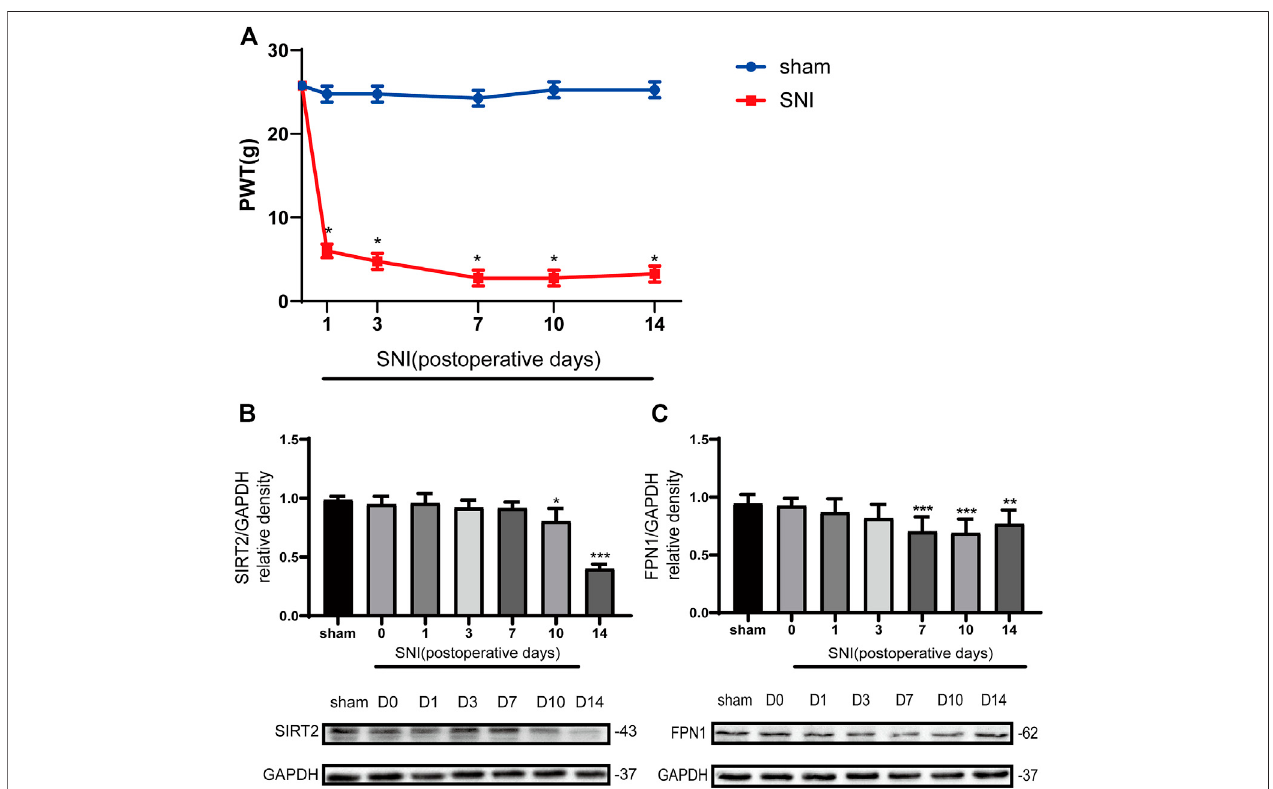
FIGURE 2 | The paw withdrawal threshold (PWT) decreased in the SNI rats, and the levels of SIRT2 and FPN1 were downregulated in the SNI rats. (A) The PWT valuestomechanical stimulation ondays 0,1,3,7,10,and14aftershamoperationorSNI. (B) Time-dependentchangesintheexpression ofSIRT2inthespinalcordof the SNI rats. (C) Time-dependent changes in the expression of FPN1 in the spinal cord of the SNI rats. The rats in the sham operation group were used as controls. Values are expressed as the mean ± SE ( n = 5 per group). * p -values of < 0.05, ** p -values of < 0.01, and *** p -values of < 0.001 for comparisons with values of the sham rats or SNI rats at baseline (day 0). SNI, spared nerve injury; SIRT2, sirtuin 2; FPN1, ferroportin